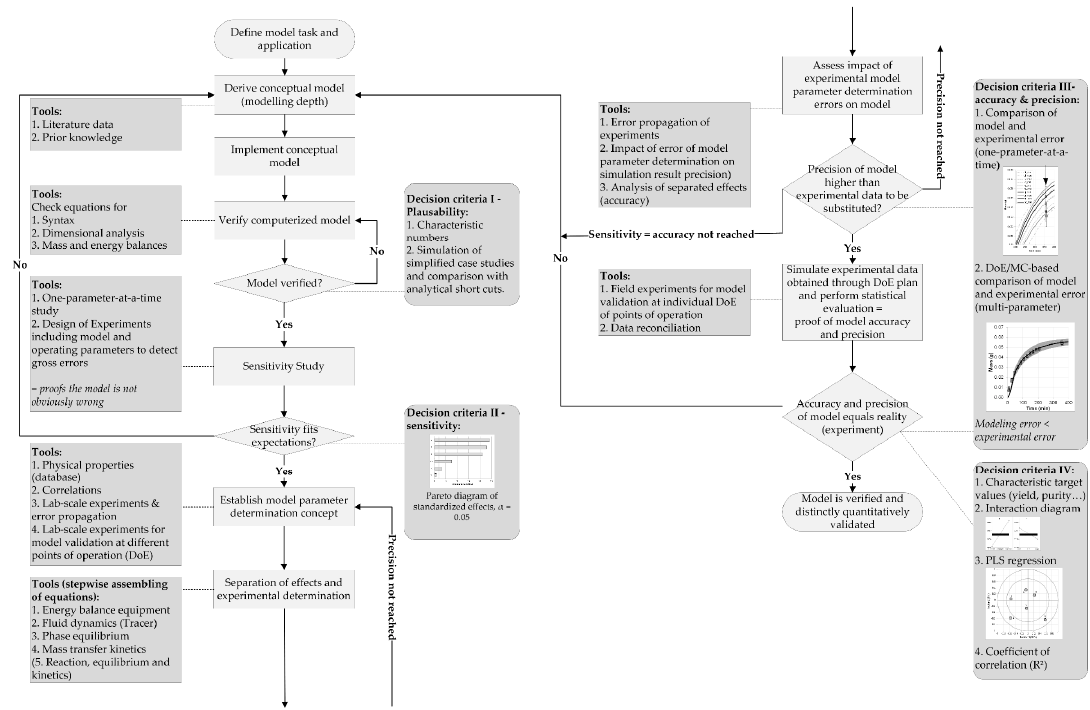
Figure 3. Workflow scheme for process model development and validation. Adapted from [15].